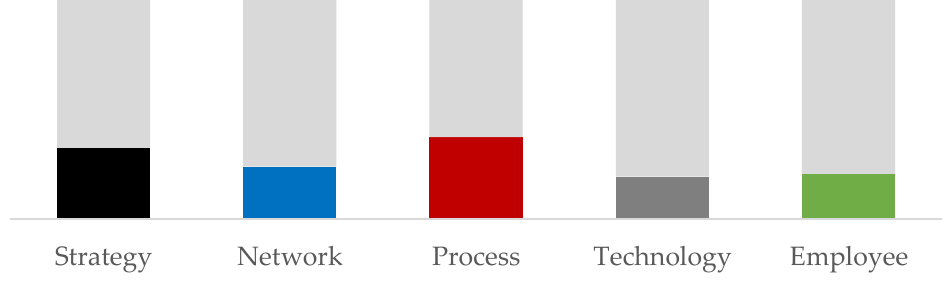
Figure 9. Level of the five logistics dimensions for the beginner profile.